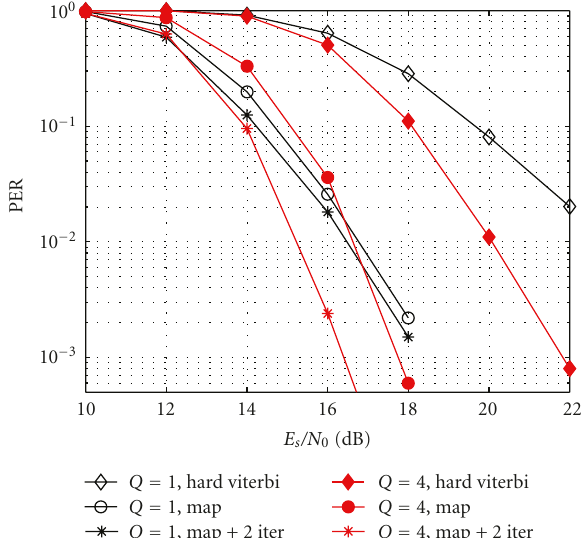
Figure 4: Configuration 2: 20MHz, STBC-CDD ( N T = 4, N s = 1, N R = 1), QPSK modulation. PER performance with (solid markers) and without (hollow markers) GO-CDM.